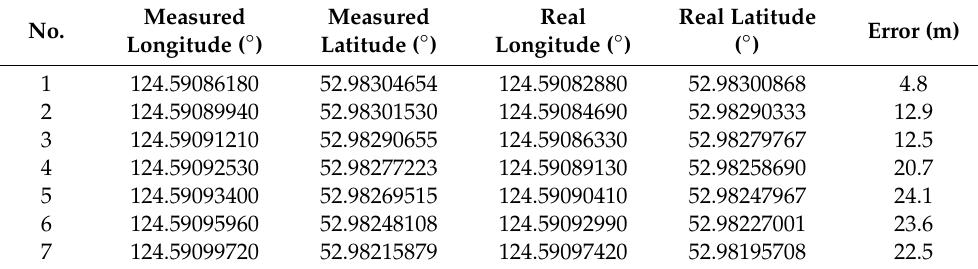
Figure 13. Measured length and actual length comparisons of pipeline at corners. Table 2. Error between measured point and actual point when odometer